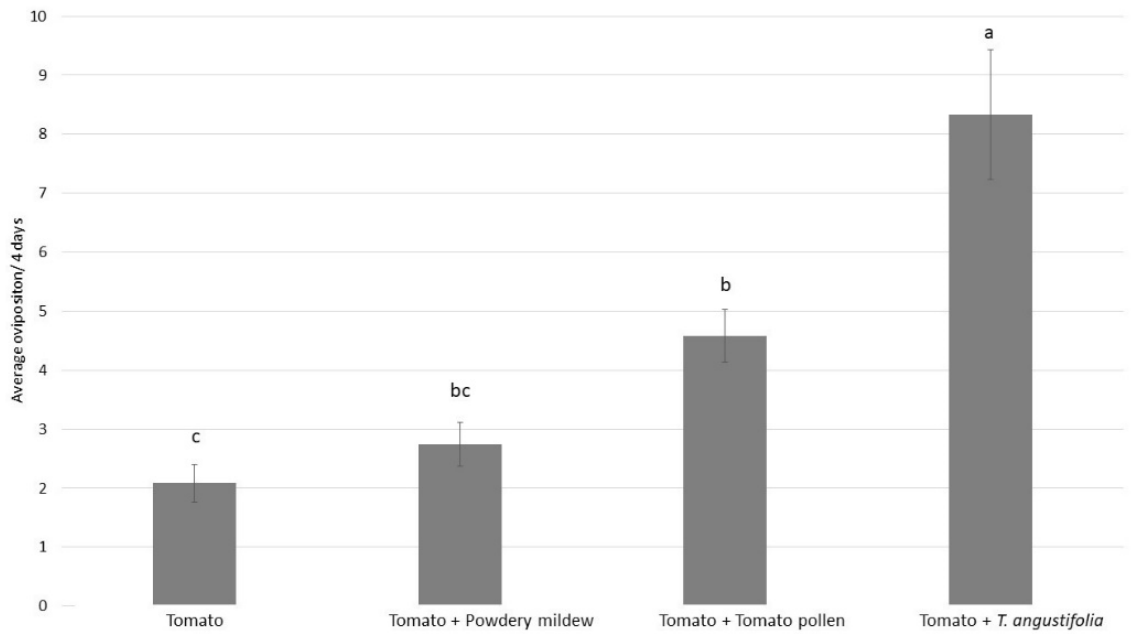
Figure 2. Average of the total oviposition over the course of 4 days (mean ± SE) for P. ubiquitus on tomato alone, tomato with powdery mildew, tomato with tomato pollen, and tomato and T. angustifolia. Different letters above the bars denote significant difference among treatments (contrast after GLM, p < 0.05).